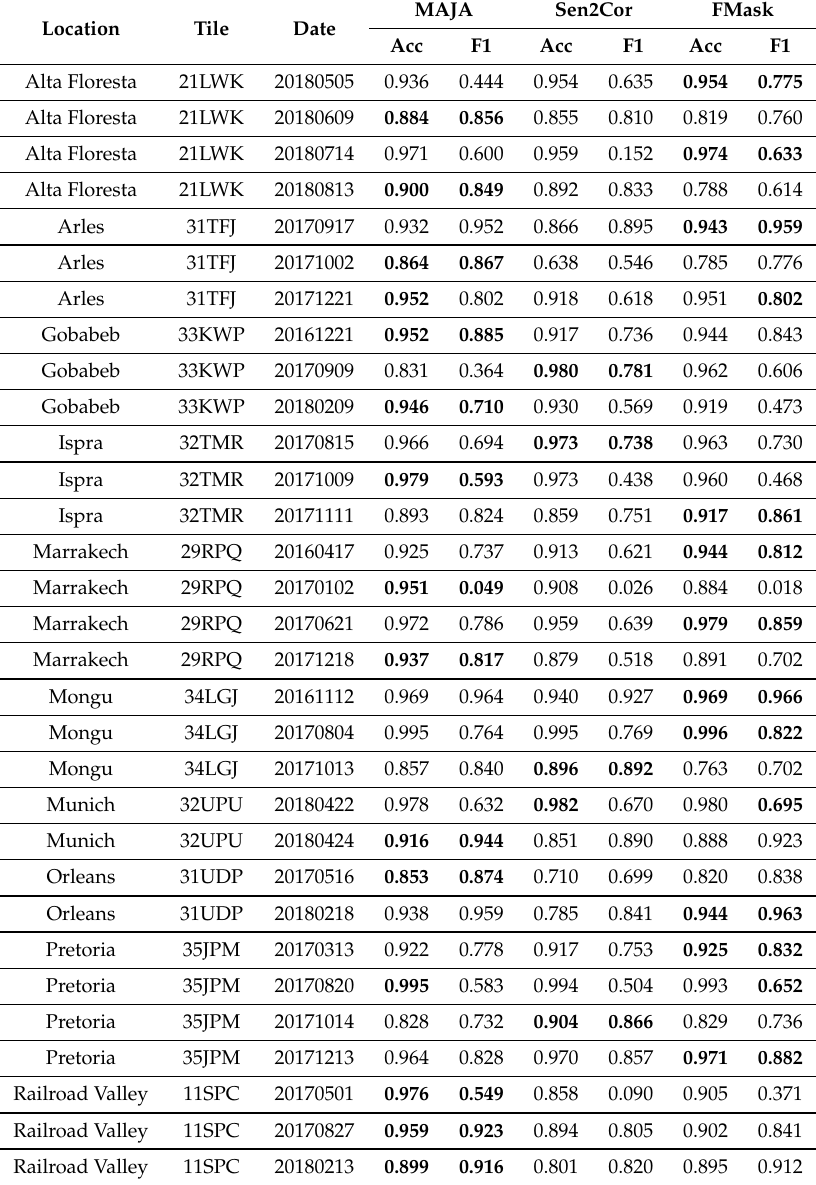
Table 7. Accuracy and F1-score for each scene, with the original masks for ALCD, Sen2Cor, and FMask and for MAJA after erosion. In bold, the best metrics for each scene. Dates are written with format YYYYMMDD to save